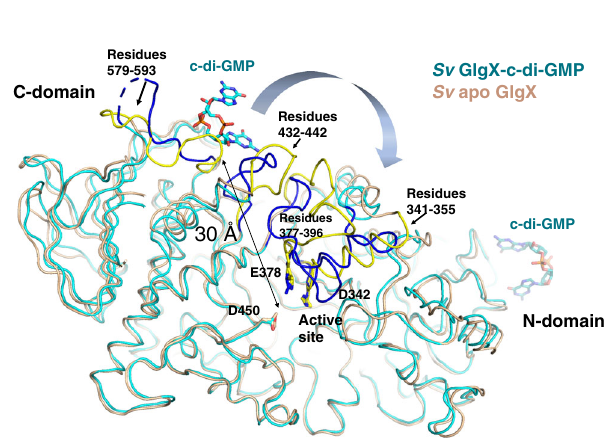
Fig.5|Structureofthe S.venezuelae GlgX-c-di-GMPcomplex.a Ribbondiagram of the S. venezuelae GlgX-c-di-GMP complex with one GlgX subunit colored cyan and the other salmon. Shown as sticks are the c-di-GMP molecules bound at each endoftheantiparalleldimer.AlsodisplayedoverthestructureisthemFo-DFcomit map,shownasabluemeshandcontouredat4.2 σ inwhichthec-di-GMPmolecules hadbeen removed prior to multiplerounds of re fi nement. There wascleardensity for each c-di-GMP molecule. b Close up of the GlgX-c-di-GMP binding interaction. Key residues mediating contacts to the c-di-GMP are shown as sticks and labeled. Hydrogen bonds from GlgX residues that specify binding to the guanine are indi- cated by yellow dashed lines. c Fluorescence polarization (FP) binding isotherm